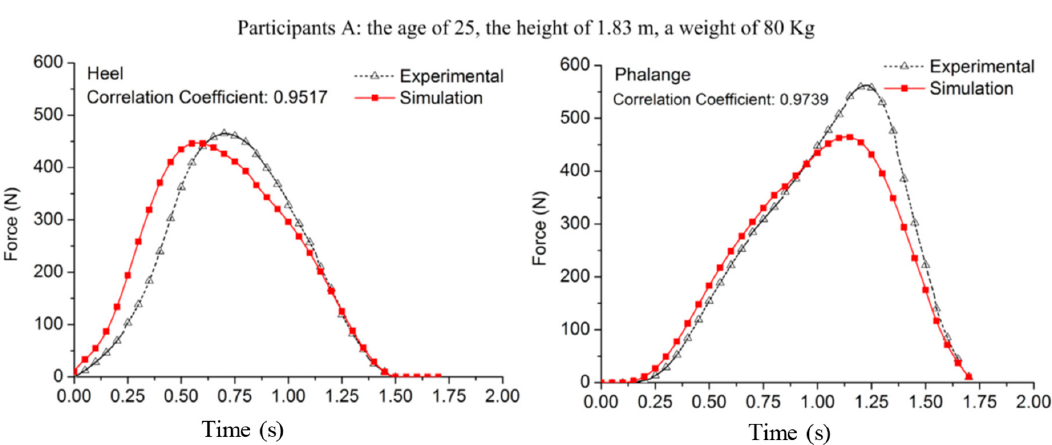
Figure 9. Comparison of the estimated and measured GRFs at heel and phalange locations for a typical test subject (after [58]).